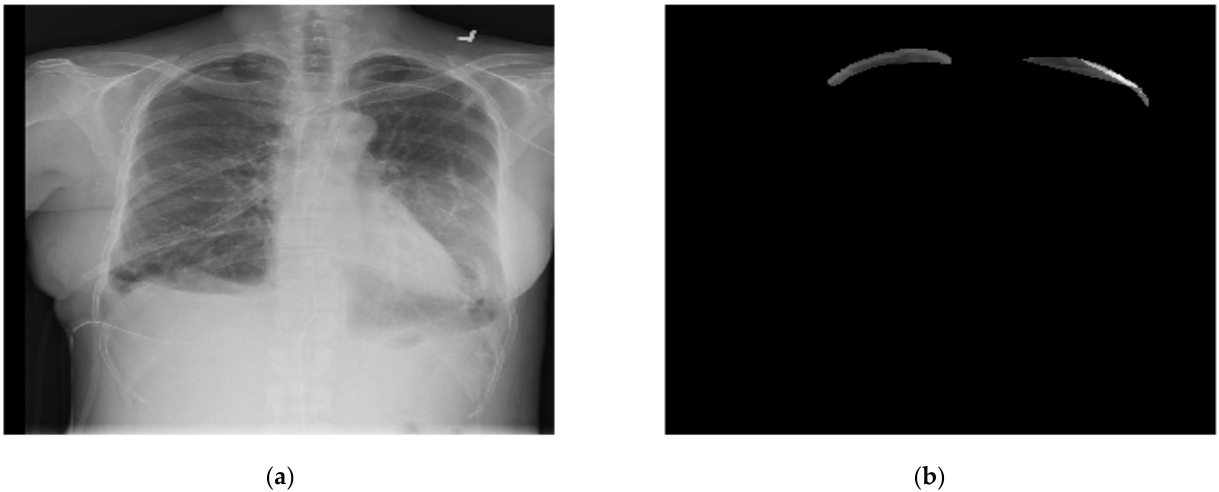
Figure 2. A training image from the dataset; ( a ) chest X-ray DICOM image ( b ) segmentation mask obtained from RLE file.